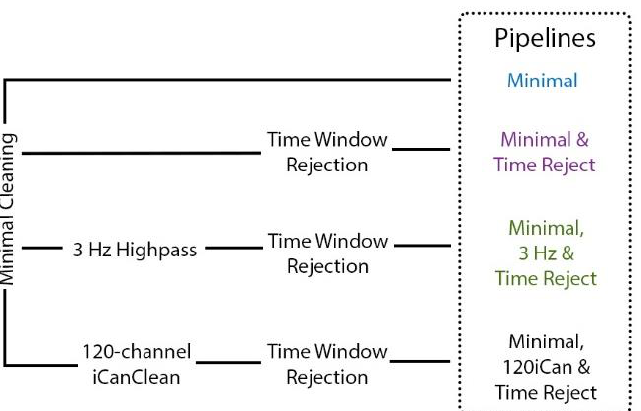
Figure 3. Overview of artifact removal pipelines. The Minimal pipeline (blue) includes basic preprocessing (filtering, channel rejection, interpolation, average re-referencing). The Minimal & Time Reject pipeline (purple) rejects bad time windows using clean_artifacts after minimal cleaning. The Minimal, 3 Hz & Time Reject pipeline (green) filters the scalp channels after minimal cleaning and with subsequent time window rejection (substituting for iCanClean). The Minimal, 120iCan & Time pipeline (black) uses all noise electrodes to clean scalp electrodes with canonical correlation analysis after minimal cleaning and with subsequent time window